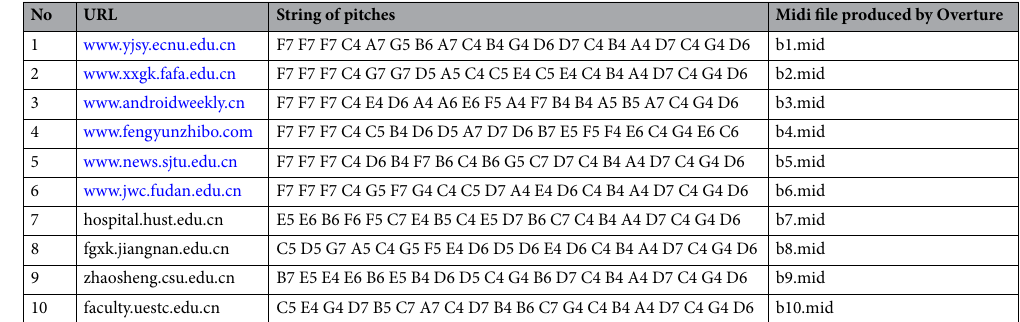
Table 3. The relationship between a URL and its string of pitches when each URL has twenty characters.